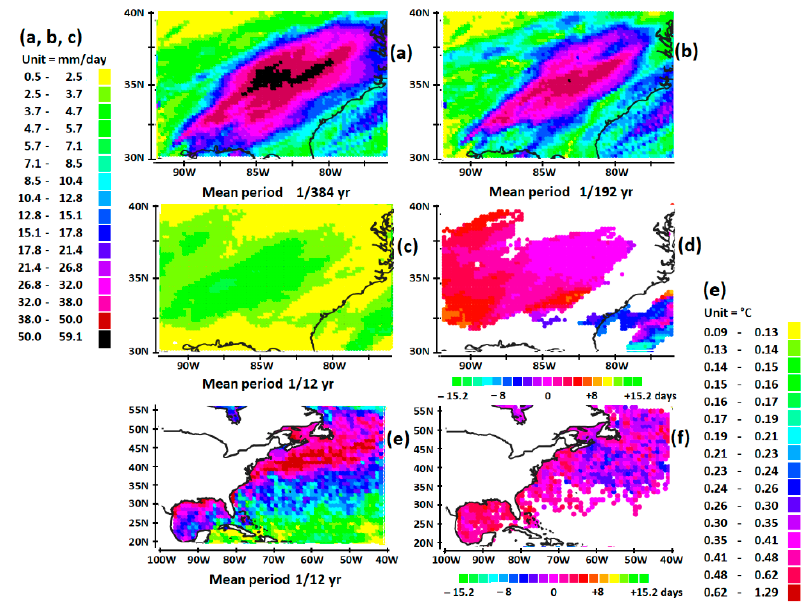
Figure 13. Extreme rainfall in Kentucky. Same conventions as in Figure 7. Time lags in ( d , f ) are expressed in relation to 6 February 2020. The time reference is the rainfall depth at 39° N, 85° W.